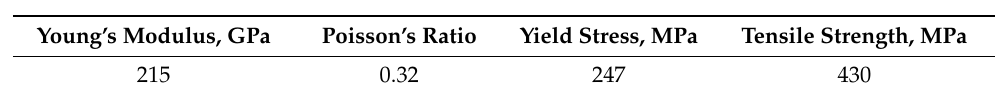
Table 2. Mechanical properties of the steel.